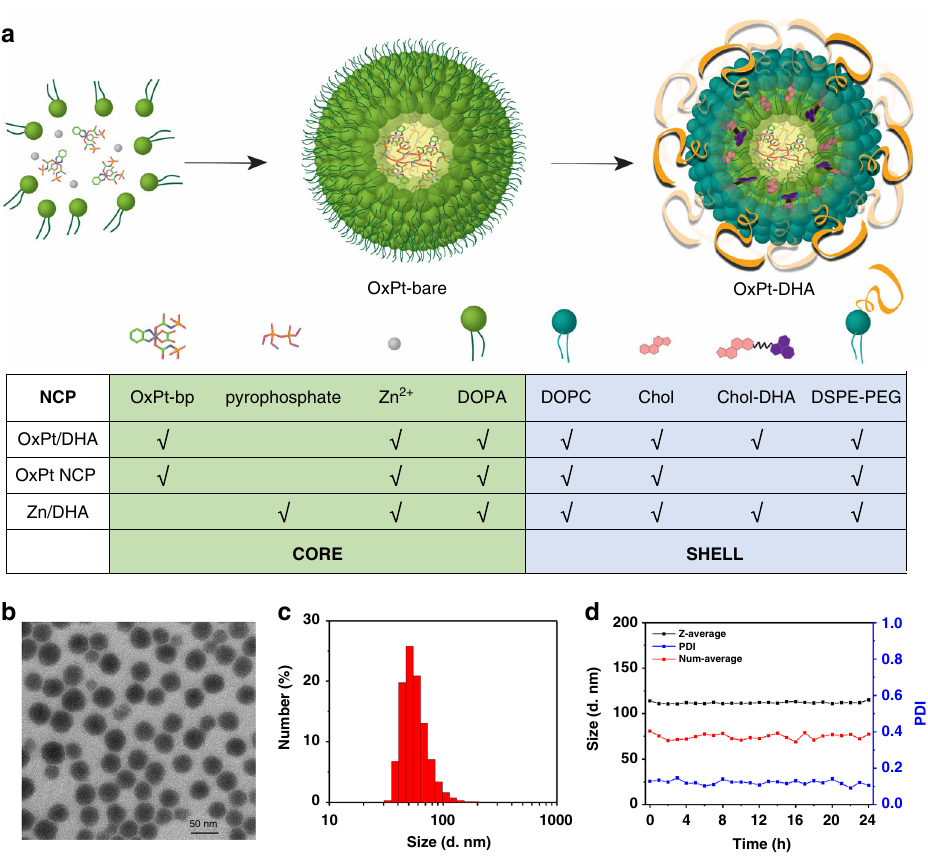
Fig. 1 Preparation and characterization of OxPt/DHA. a Schematic illustration showing layer-by-layer construction of the hybrid core-shell structure of OxPt/ DHA. The OxPt/DHA consists of an OxPt prodrug coordinated to Zn 2 + ions in the core and chol-DHA in the lipid shell. Compositions of the three NCPs investigated are also shown. b TEM image of OxPt/DHA. c Number-average diameter of OxPt/DHA characterized by DLS. d Stability test of OxPt/DHA at 37°C in the presence of BSA (5mg/mL). OxPt oxaliplatin, DHA dihydroartemisinin, TEM transmission electron microscopy, DLS dynamic light